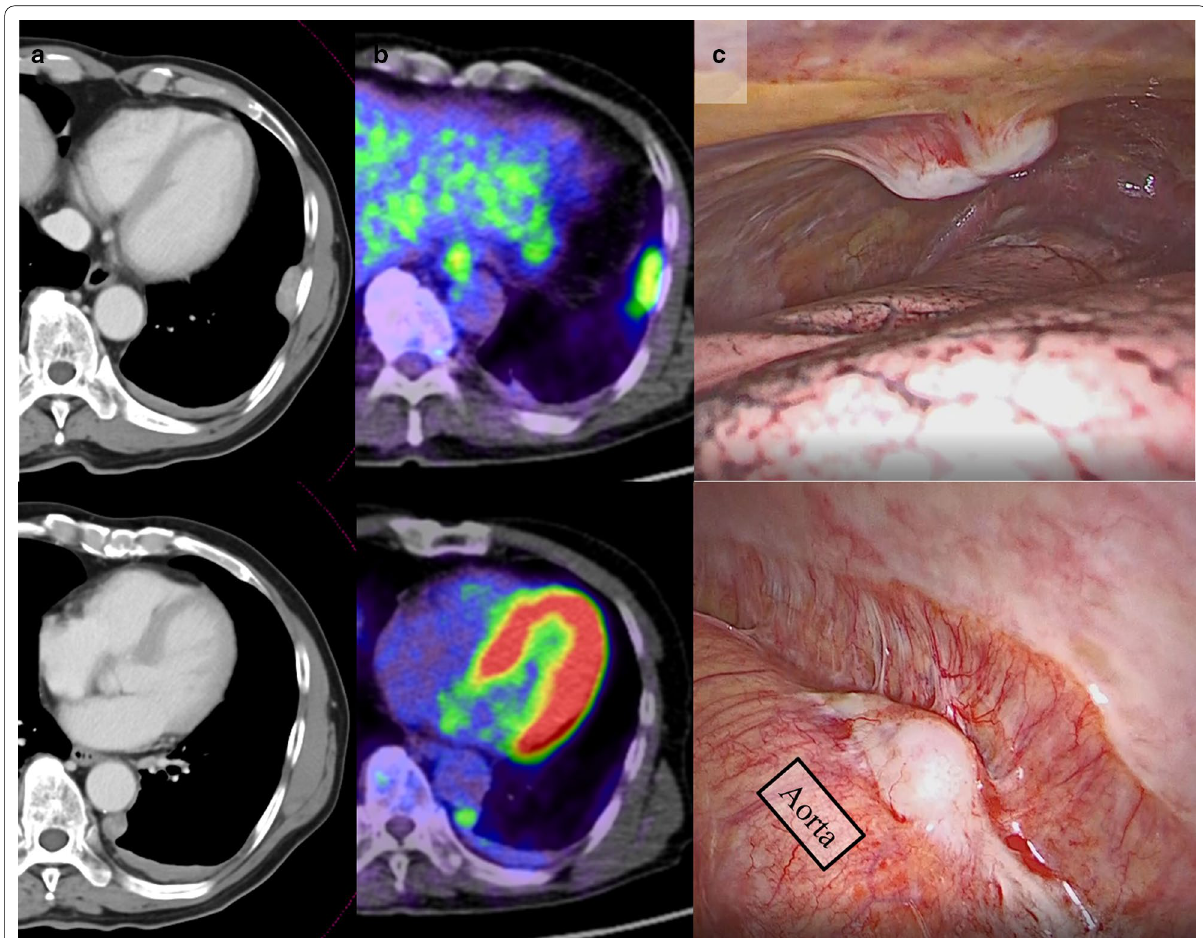
Fig. 1 Computed tomography (CT) and 18 F-fluorodeoxyglucose (FDG) positron emission tomography (PET)/CT. a CT of the chest revealed multiple pleural nodules, including a 2.7 1.8 1.1 cm nodule inside the mid-axillary line of the 8th rib and a 1.3 × × 9th thoracic vertebral body on the dorsal side of the descending aorta. b FDG-PET/CT maximum standardized uptake values of the lateral nodule and the nodule of the dorsal side of descending aorta were 4.93 and 3.18, respectively. c Intraoperative images of the nodule inside the mid-axillary line of the 8th rib and the nodule at the height of the 9th thoracic vertebral body on the dorsal side of the descending